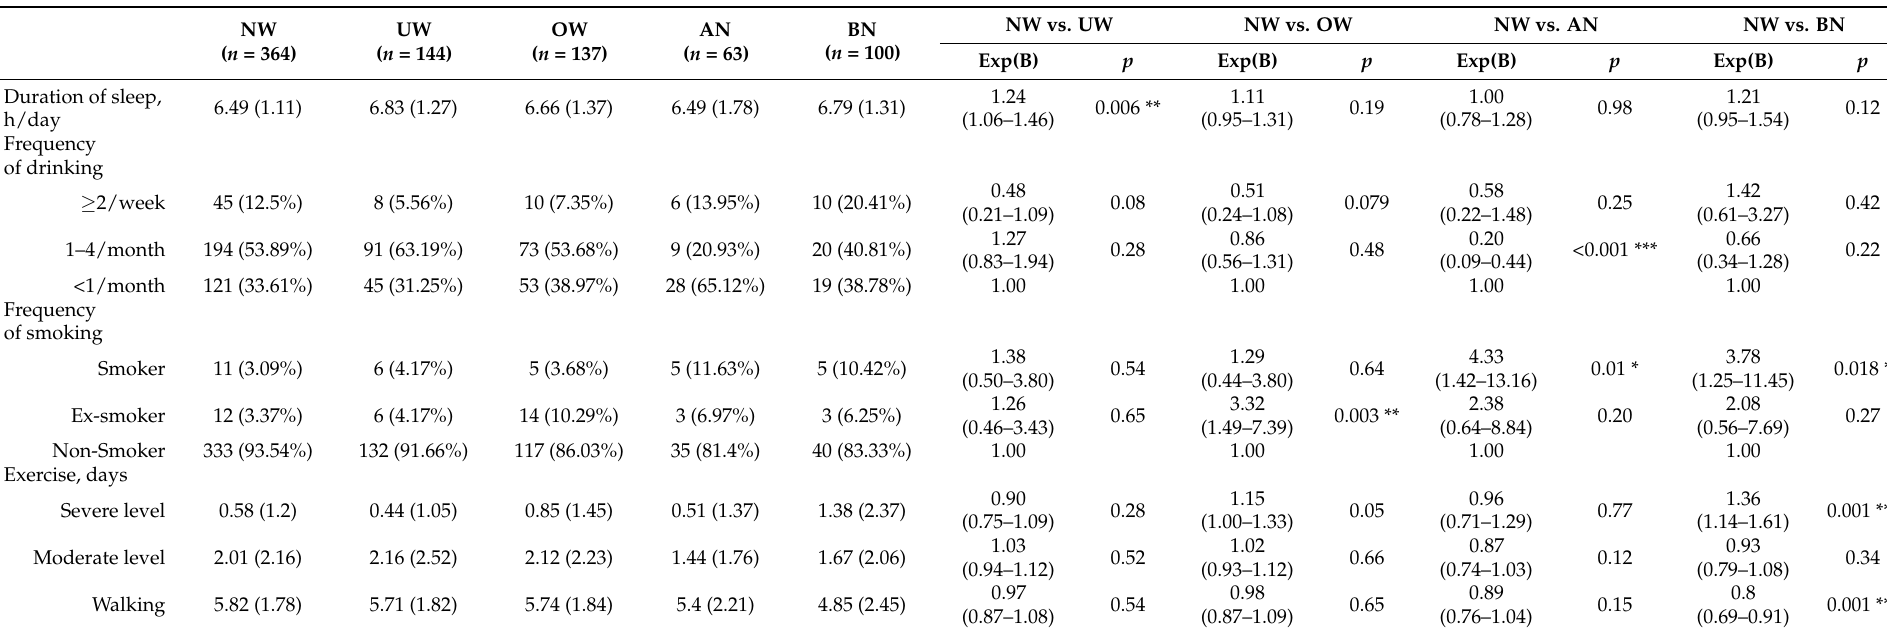
Table 3. Health behaviors in young women with UW and OW, and patients with AN and BN compared to women with